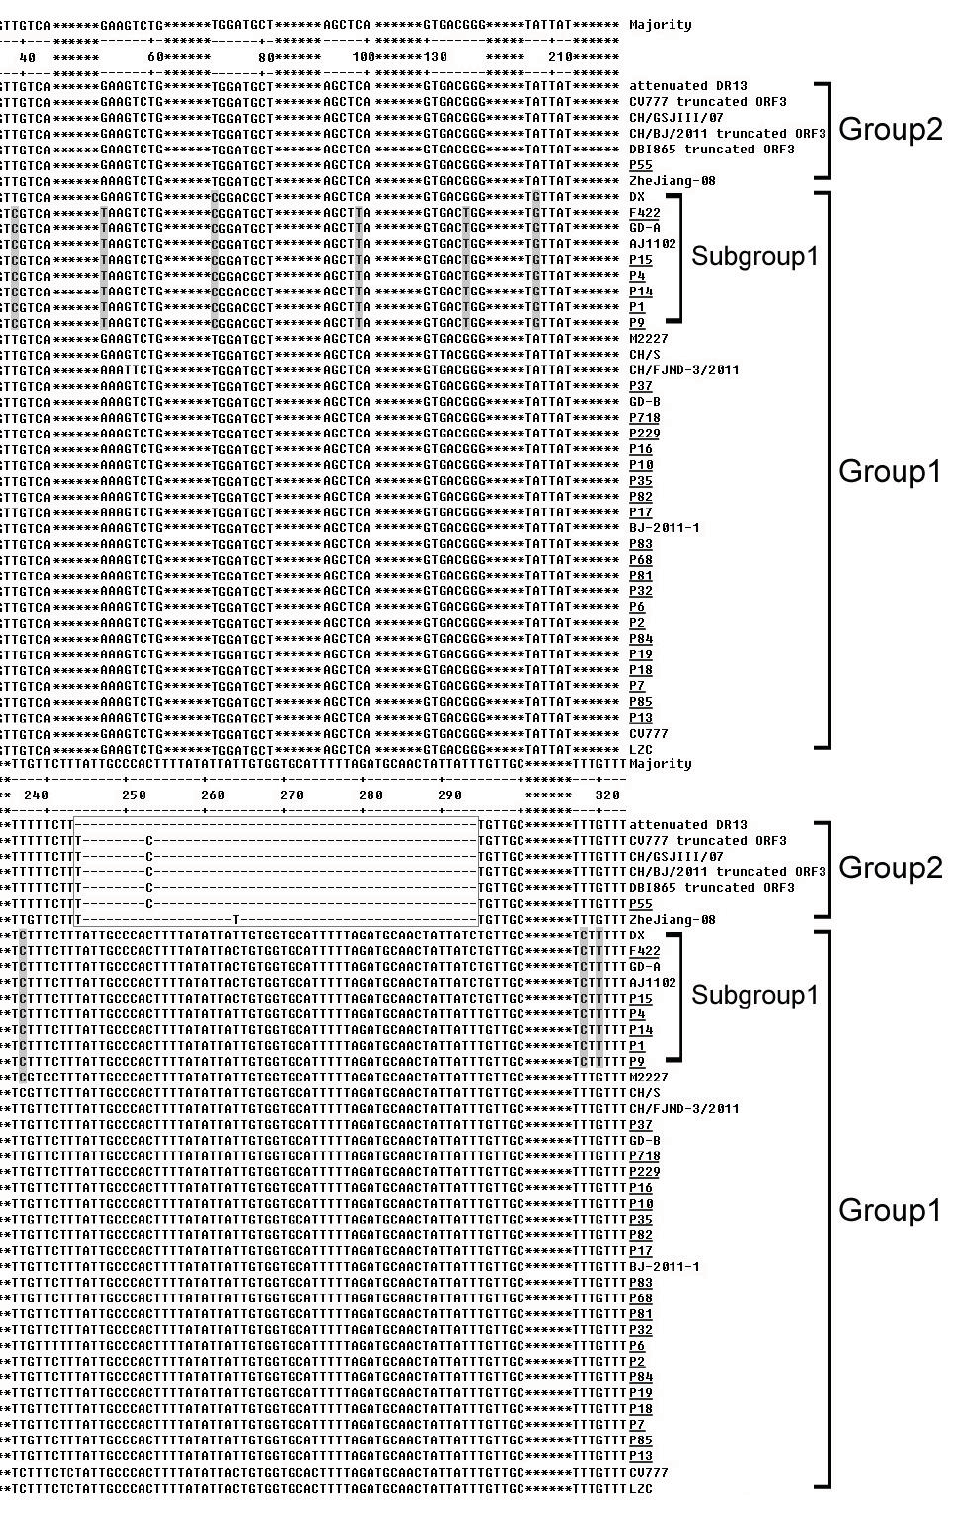
Figure 1. Alignment of nucleotide sequences of ORF3 genes of Fujian PEDV strains and reference strains. The asterisks represent the segments with no differences and not shown in this figure. The dashes represent deleted nucleotides. The shadows indicate the unique substitutions of chosen strains. The boxes indicate the unique insertions or deletions of chosen strains. The underlines represent the Fujian field samples in this